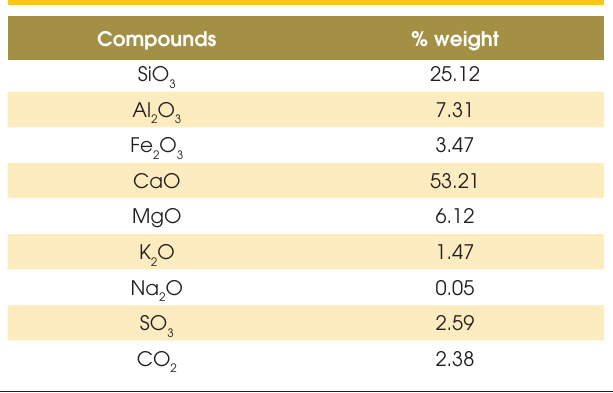
Table 2 – Chemical properties of the